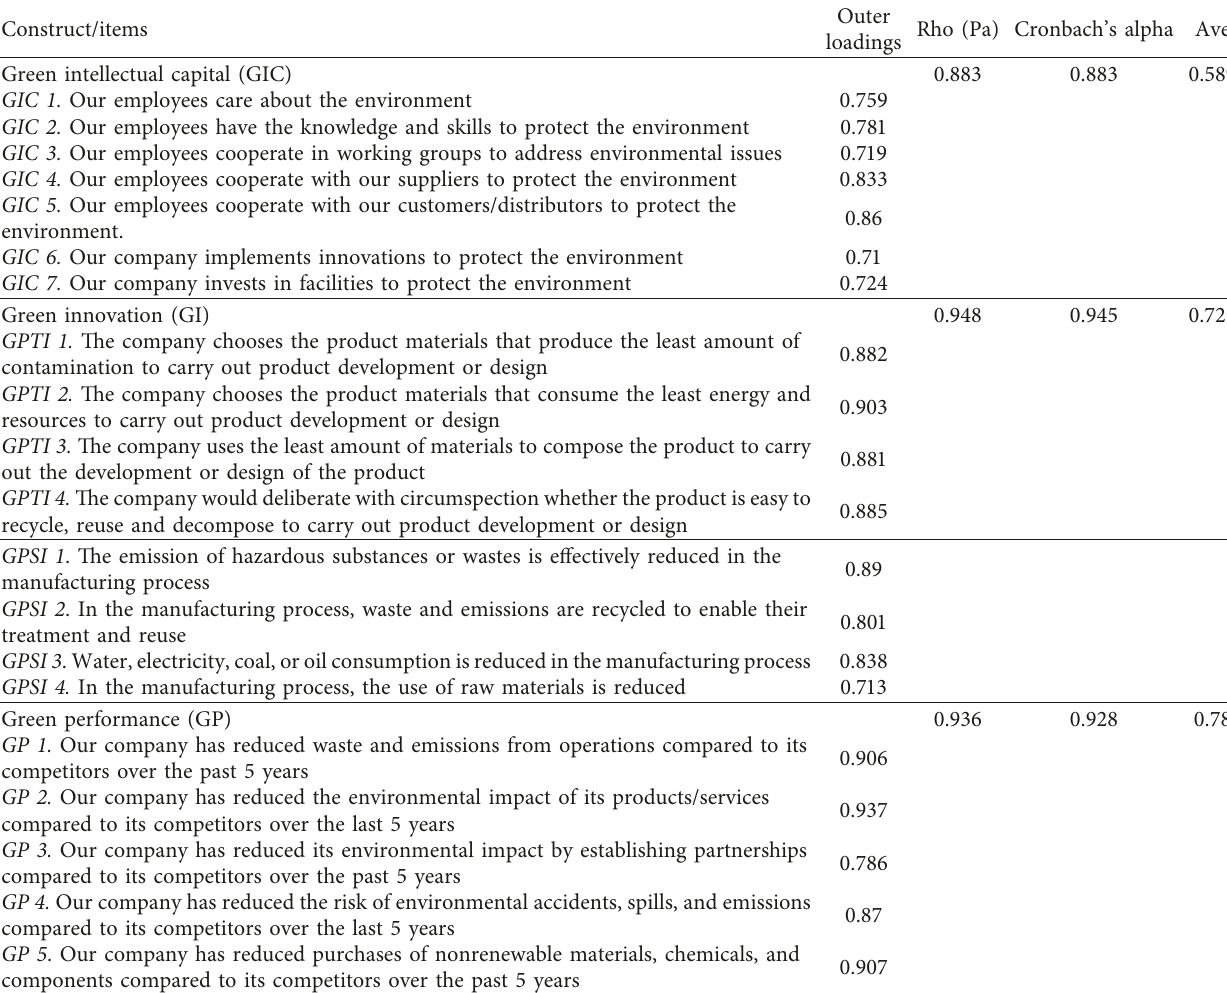
Table 4: Measurement model: external loadings, construct reliability, and convergent validity.